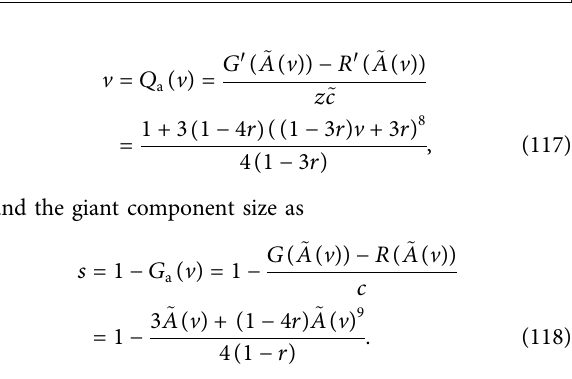
FIGURE 6 | Effect of different types of attacks on heterogeneous networks. Shown is the giant component size of the heterogeneous example network after a random attack (red, Eq. 108 ), a viral attack (green, Eq. 128 ) and an optimal degree-targeted attack (blue, Eq. 118 ). Targeting the nodes of highest degree destroys the giant component very quickly. The viral attack is almost as ef fi cient in destroying the network, while requiring much less information on the node